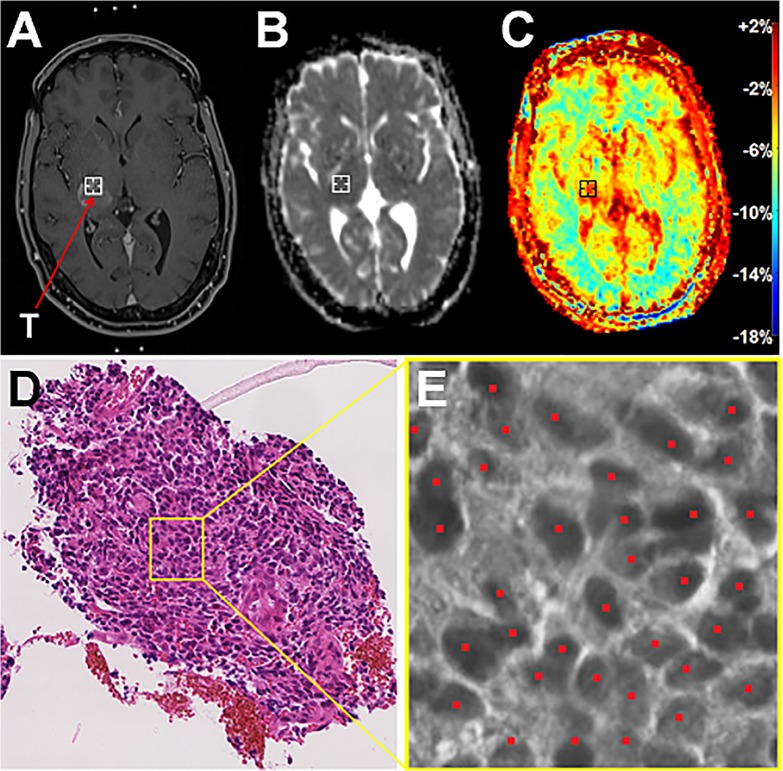
Correlation of the biopsy point on the MTRasym image and the ADC image with histology and semi-automatic cell counting.
A) Target point T of the biopsy trajectory on the intraoperative CE-T1 image of a 45-year-old male with glioblastoma (patient 15). It lies in the contrast-enhancing area. Marks of the stereotactic biopsy ring are visible frontally and occipitally. B) Target point T on the ADC image which was coregistered to the intraoperative CE-T1 image in MITK with an automatic multi modal rigid registration algorithm. The average ADC value of 3x3x3 voxels (= 27mm3) was read out to account for possible inaccuracies in coregistration and biopsy sampling. In the shown example, it yielded ADC = 659mm2/s. C) Target point T on the MTRasym image which was coregistered to the intraoperative CE-T1 image in MITK with an automatic multi modal rigid registration algorithm. The average MTRasym value of 3x3x3 voxels (= 27mm3) was read out to account for possible inaccuracies in coregistration and biopsy sampling. In the shown example, it yielded MTRasym = -1,72% D) Corresponding slice of the 1 mm3 biopsy specimen (HE stain) in x20 magnification obtained at the target point T. E) Exemplary section to illustrate semi-automatic cell counting with the ImageJ plugin ITCN. Tumor cells that were recognized by the algorithm are marked red. Overall cell density of the shown biopsy specimen was 1684 cells/mm2.